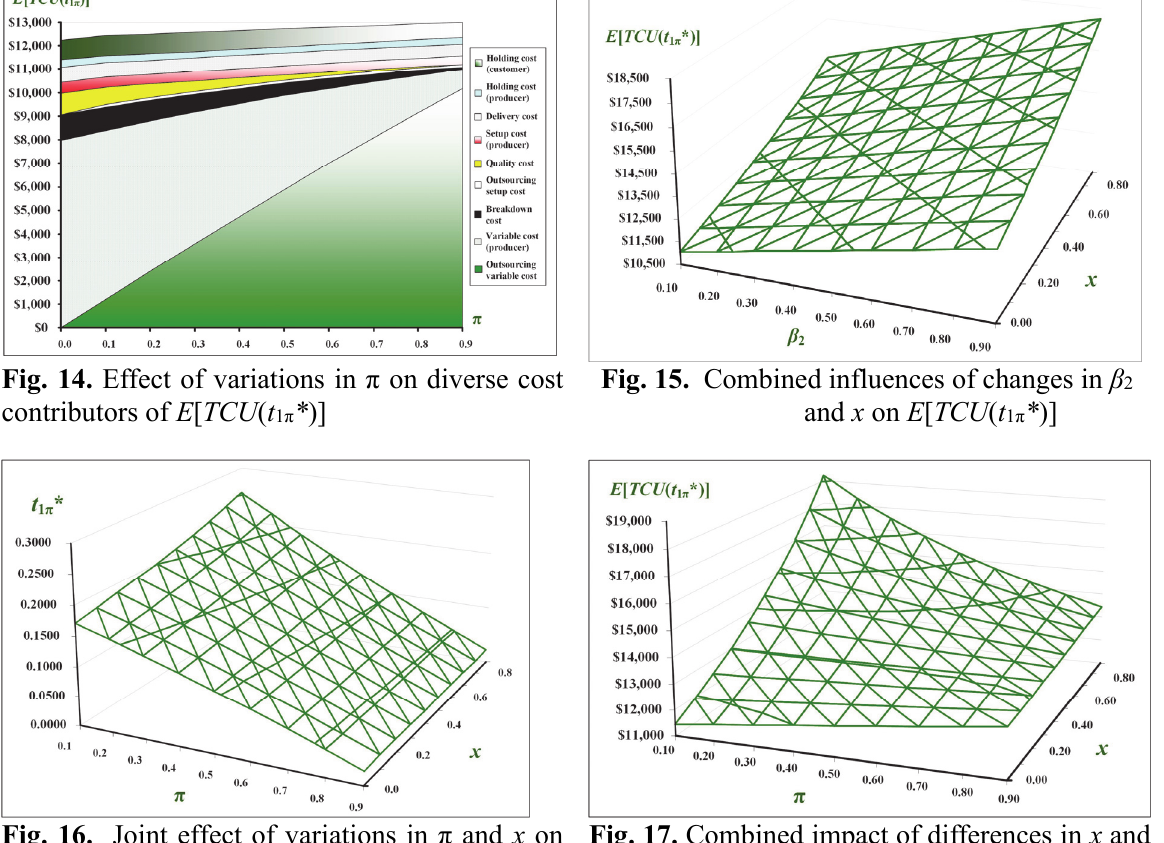
Fig. 16. Joint effect of variations in π and x on t 1 π *